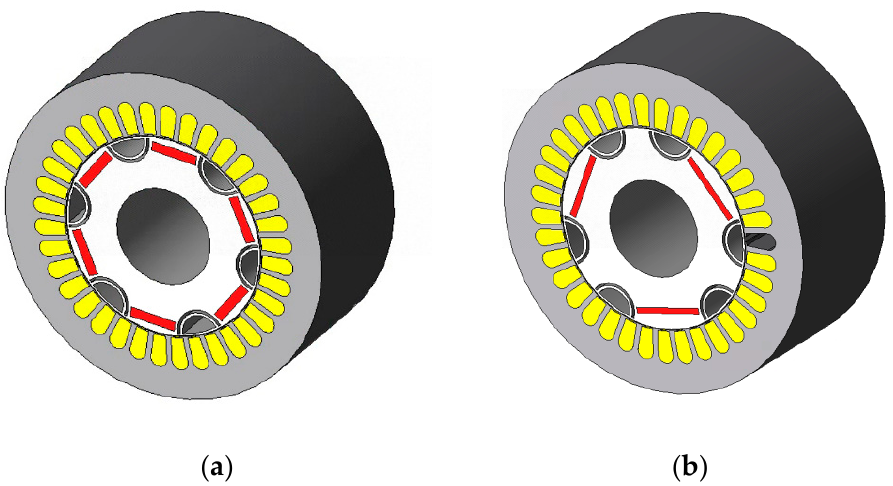
Figure 19. Three-dimensional models of the two machines. ( a ) FIMM. ( b ) CP-FIMM.